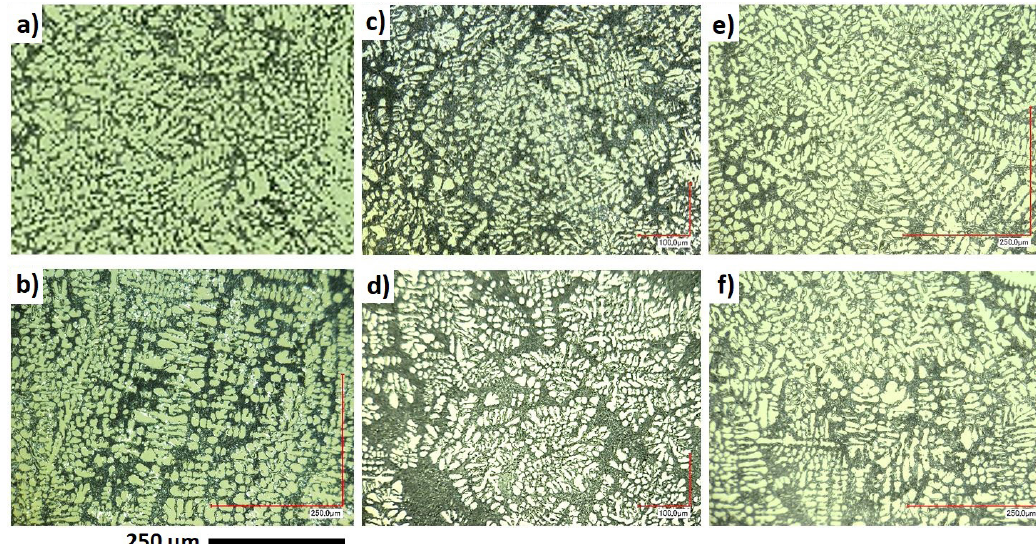
Figure 5. Directionally solidified A360 aluminium with solidification velocity of 2 mm/s. a,b) reference; c,d) B=0.4T, I=157 A; e,f) B=0.4T. Top row is perpendicular cross section, bottom is parallel to solidification direction.